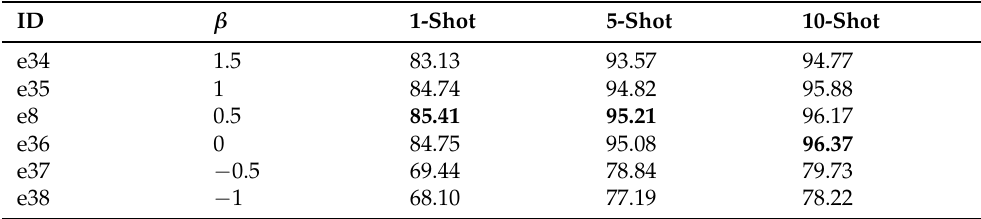
Table 7. The results of different values of β . ( f θ : Resnet12, data: setting-2, method: f + GC, filter-size: 8 × 8, channel: top-24).